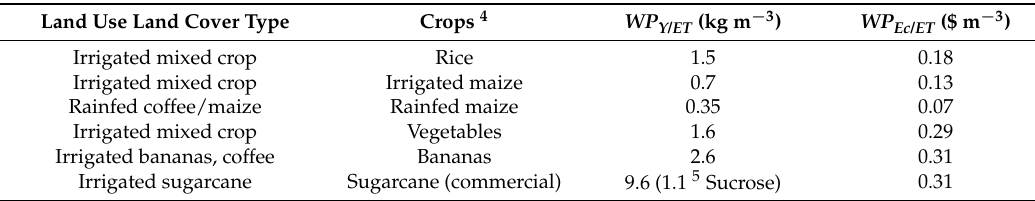
Table 7. Crop yield and economic water productivity for main agricultural crops in the Upper Pangani River Basin.